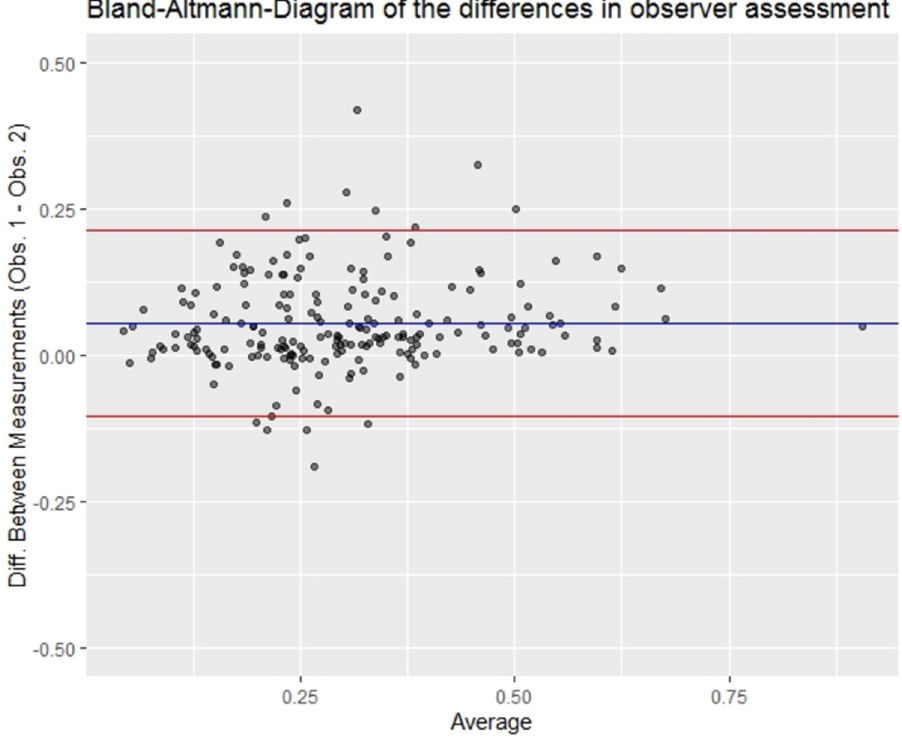
Fig 6. Bland-Altmann-Diagram. The Bland-Altmann-Diagram suggests a good agreement of the image graders that evaluated the size of the FAZ (ICC of 0.788).